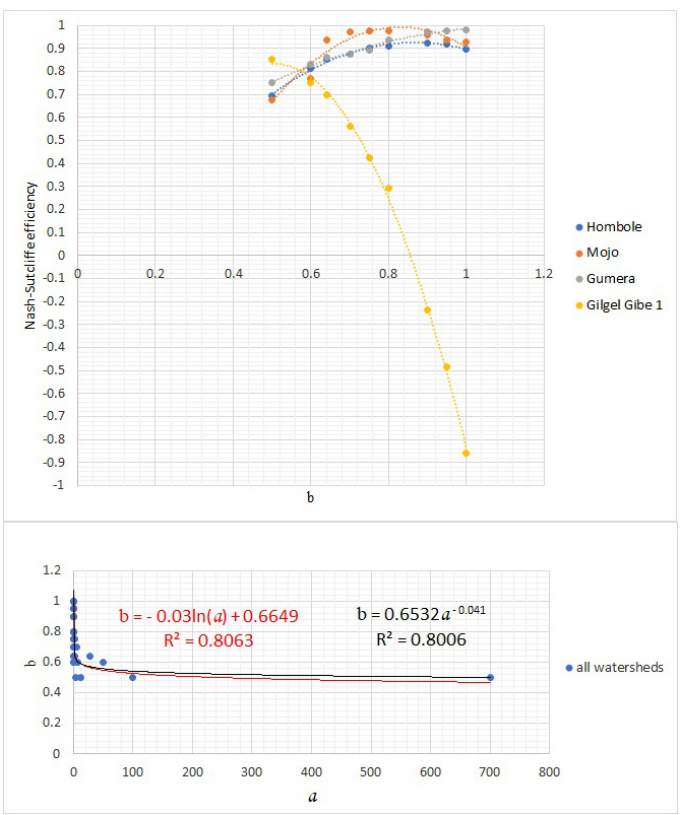
Figure 25. The relationship between exponent b versus the Nash–Sutcliffe efficiency and the coeffi- cient a versus the exponent b when the topographic factor is calculated using the equation that was proposed by [33].